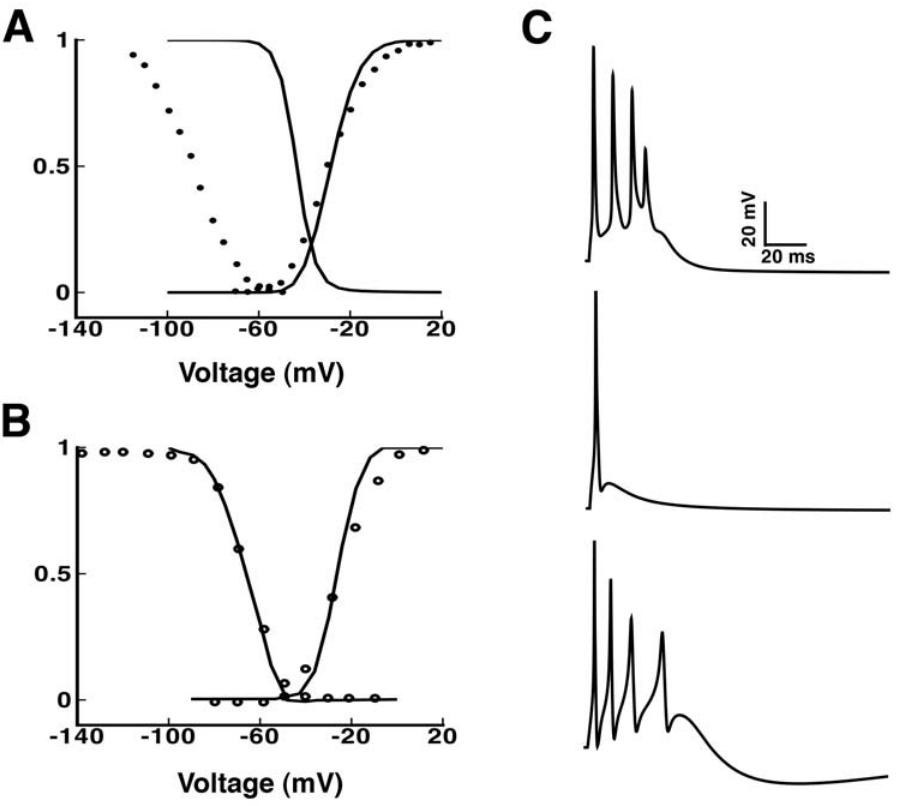
Figure 1. Accurate channel kinetics are important to determine bursting mechanisms. (A) Na + channel activation and steady state inactivation curves generated by the Migliore CA3 model are shown (lines) with superimposed experimental data from Sah et al. [34] on which the model is based (symbols). (B) Activation and steady state inactivation curves generated by the Markov Na V 1.1 model are shown (lines) with superimposed experimental data from Lossin et al. (6) on which the model is based (symbols). (C) The single compartment model is stimulated with an injection current of 0.2nA for 5 ms. Top panel: Window current resulting from the large artificial rightward shift in the Na + channel inactivation curve results in a burst generated by the Migliore model. Middle panel: Substitution of the Markov Na V 1.1 model into the Migliore model abolishes the window current, and consequently, the burst. Lower panel: Our CA3 model does not rely on Na + window current for afterdepolarizing potential (ADP) generation. The afterdepolarizing potential (ADP) results from T-type Ca 2 +